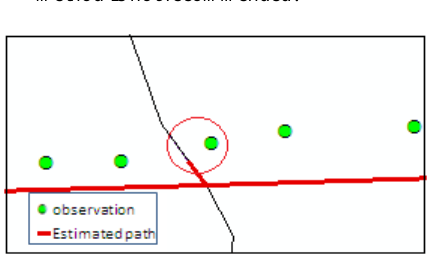
Figure 2. An example of weakness in point-to-point method 2.2.2 Point to curve: In this method, each of the obtained points is mapped on the closest arc of the network. The